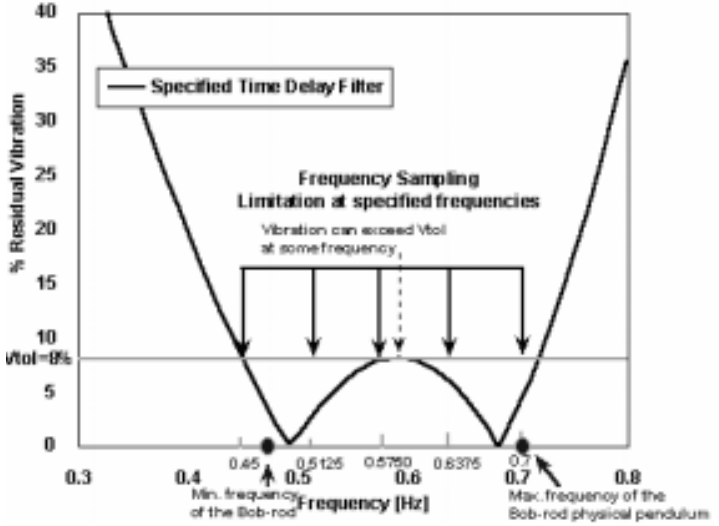
Fig. 7. Limits of the insensitivity range to be considered by the frequency sampling method to limit vibration of the bob-rod mini overhead